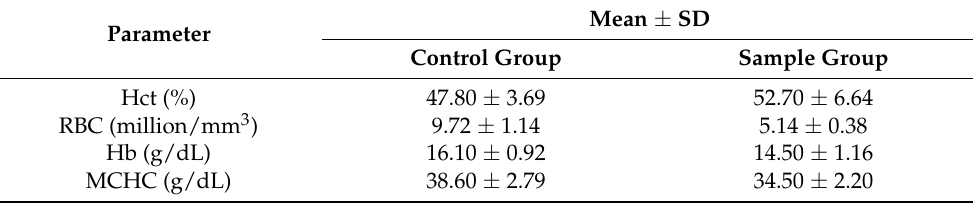
Table 3. Hematological parameters after administration of honey with sulfonamide residues to rats.